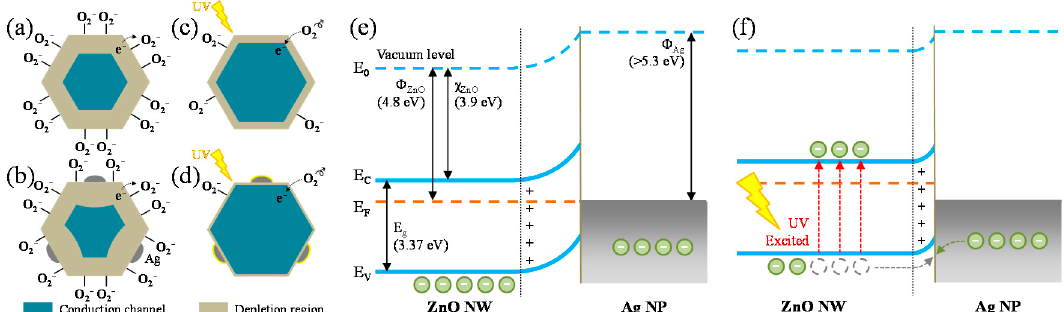
Figure 10. Schematic of the UV detection mechanism of the Ag-decorated ZnO NW PDs: Depletion/conduction channel in ( a , c ) bare ZnO NWs and ( b , d ) Ag-decorated ZnO NWs in a dark state and upon UV exposure, energy-band diagrams for the Ag/ZnO heterojunction ( e ) in a dark state and ( f ) upon UV exposure.